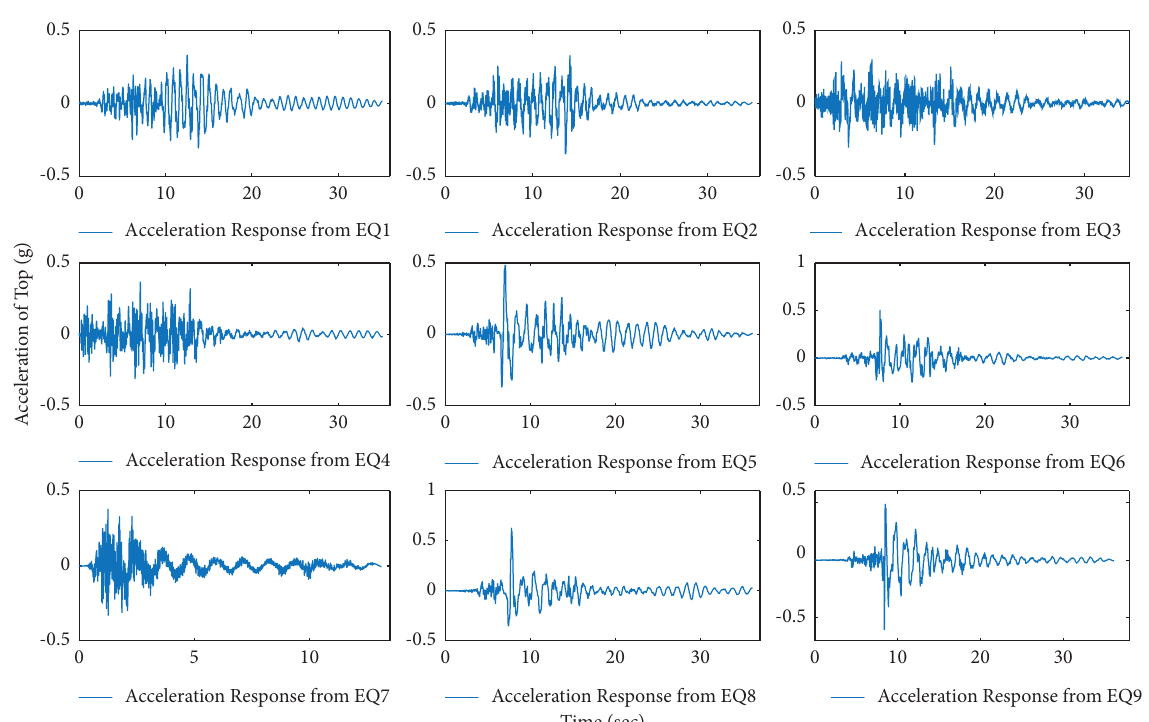
Figure 8: Acceleration response of the structure due to all records of loading